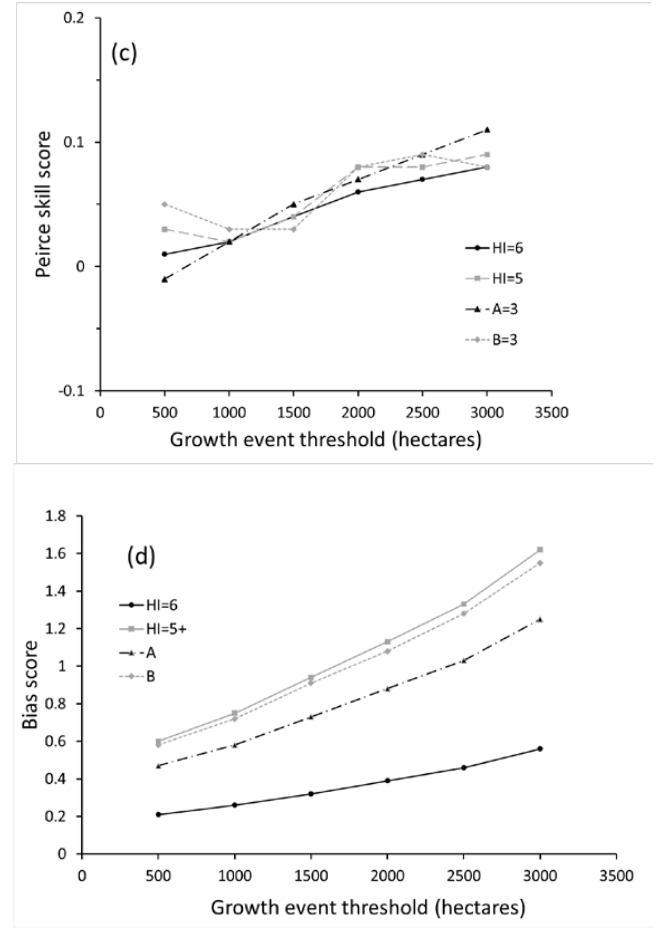
Figure 5. ( a ) True positive ratio (TPR) and Miss ratio (MR) for index threshold values of 6 and 5, for event growth thresholds from 500 to 3000 ha. ( b ) TPR and MR for HI A = 3 and HI B = 3 , for event growth thresholds from 500 to 3000 ha. ( c ) Peirce skill scores for index thresholds of 5 and 6, and component thresholds of 3. ( d ) bias scores for index thresholds of 5 and 6, and component thresholds of 3.